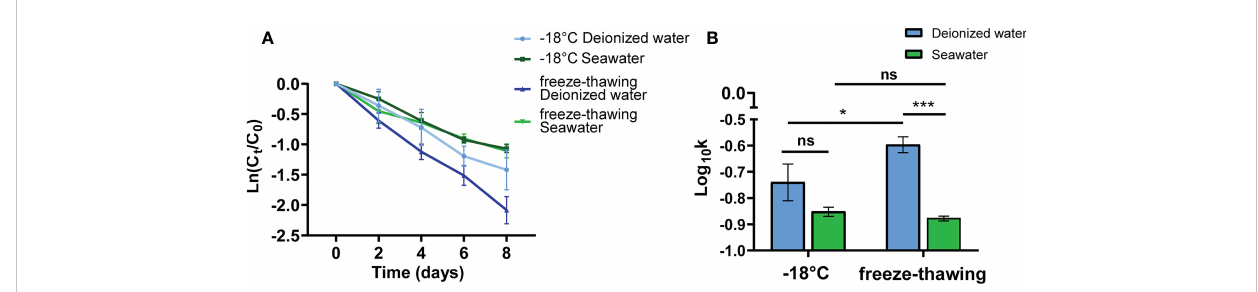
FIGURE 3 The protective effect of seawater on SARS-CoV-2 pseudovirus at -18°C. (A) The decay curves over time (days) of SARS-CoV-2 pseudovirus, which was solutes in seawater or deionized water, on PE plastic at -18°C or under freeze-thawing. The treatment condition is freezing and thawing once a day, and virus activity is tested once every two days. (B) Decay rate constants k of SARS-CoV-2 pseudovirus at -18°C and under the condition of freeze-thawing cycles. ns., no signi fi cantly difference; *p<0.05;